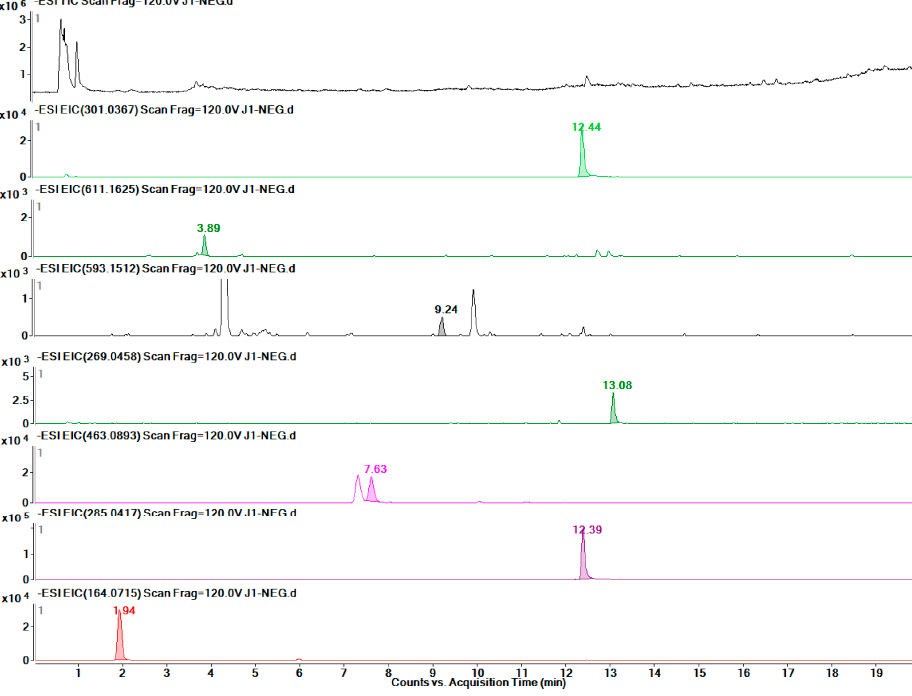
Figure 11. TIC of the J part and EICs of each of the seven metabolites.